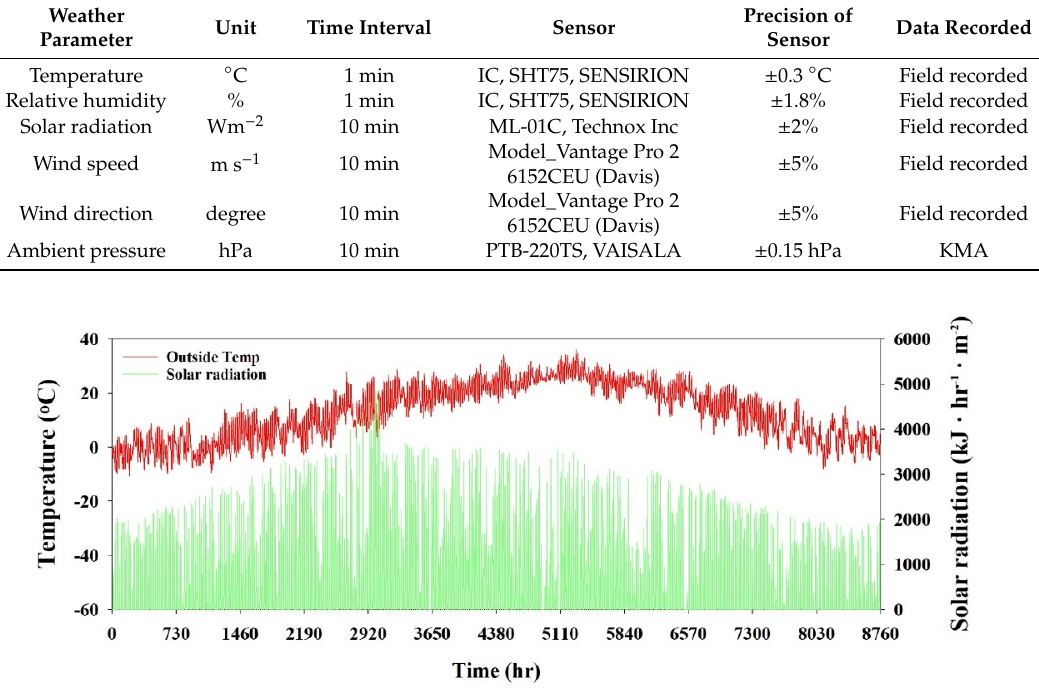
Figure 4. Temperature and solar radiation outside the greenhouse from January to December 2019.